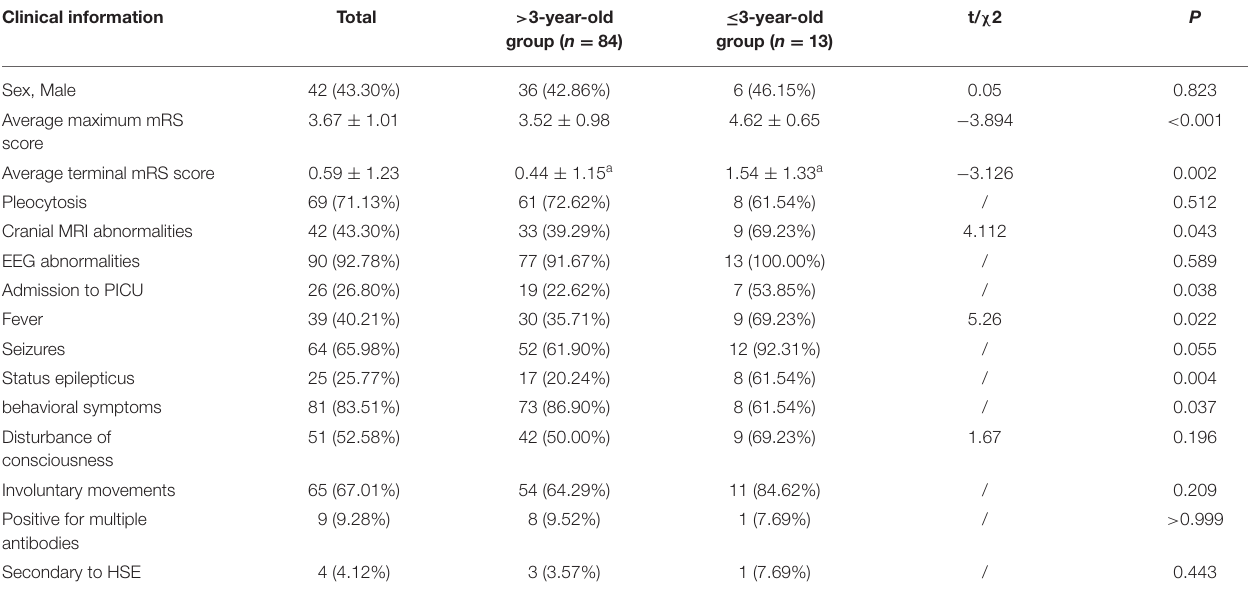
TABLE 6 | Comparison of clinical data of patients with anti-NMDAR encephalitis, between the > 3-year-old group and the ≤ 3-year-old group, case (%). Clinical